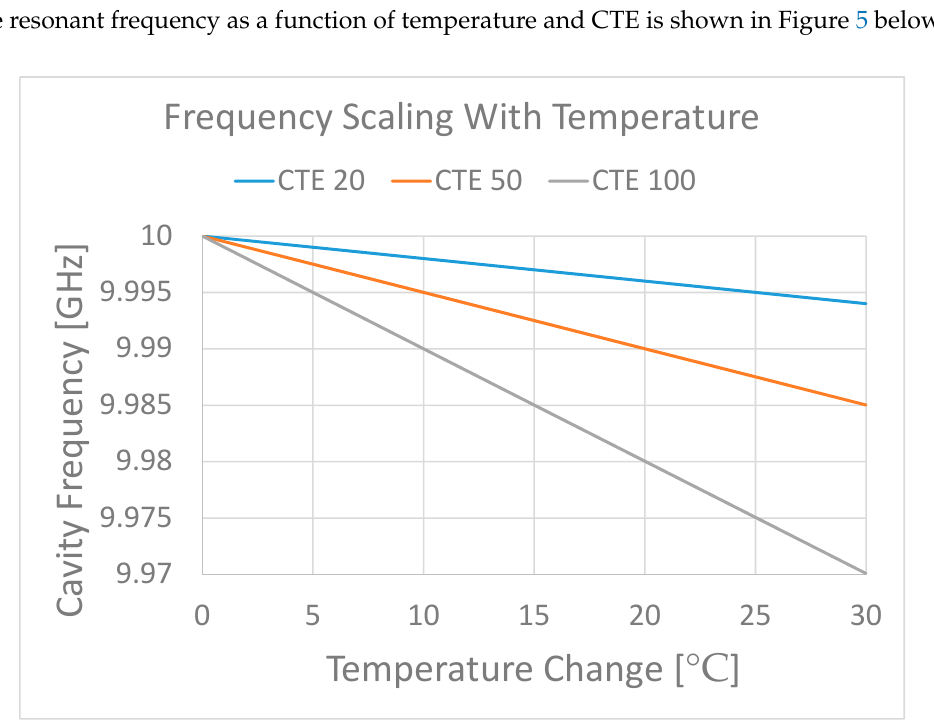
Figure 5. Frequency scaling of 10 GHz TE 101 Resonant Cavity – Temperature versus CTE.